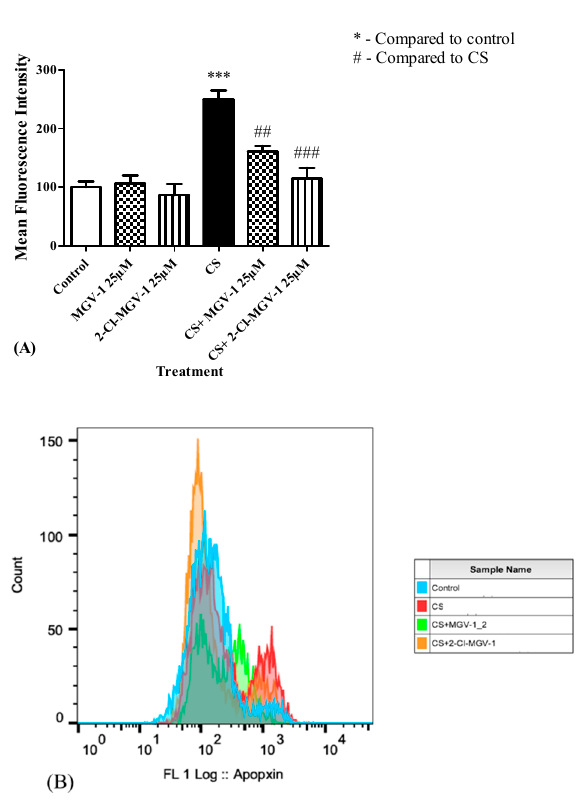
Figure 12. Apoptosis levels in H1299 lung cancer cells as measured by FACS. The fluorescence intensity was determined using FACS in ( A ) a bar graph and ( B ) a representative histogram. Results are expressed as mean ± SEM ( n = 5 in each group). *** p < 0.001 vs. control, ## p < 0.01 and ### p < 0.001 vs. CS. CS = cigarette smoke.